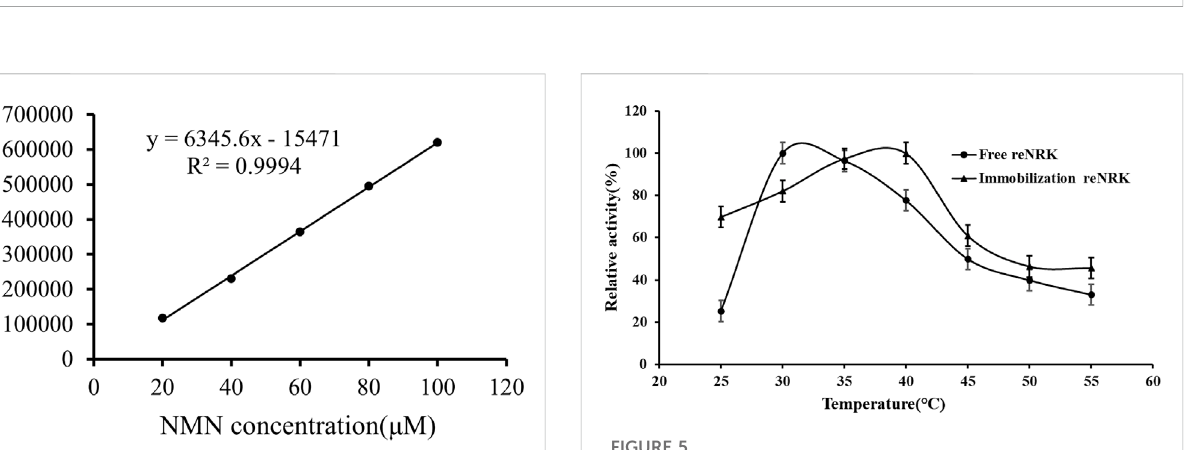
FIGURE 5 The optimal reaction temperature of the re Sc NRK1. The optimal reaction temperature of the re Sc NRK1 toward NR was determined under the standard assay conditions as above, except temperatures ranging from 25 ° C to 55 °